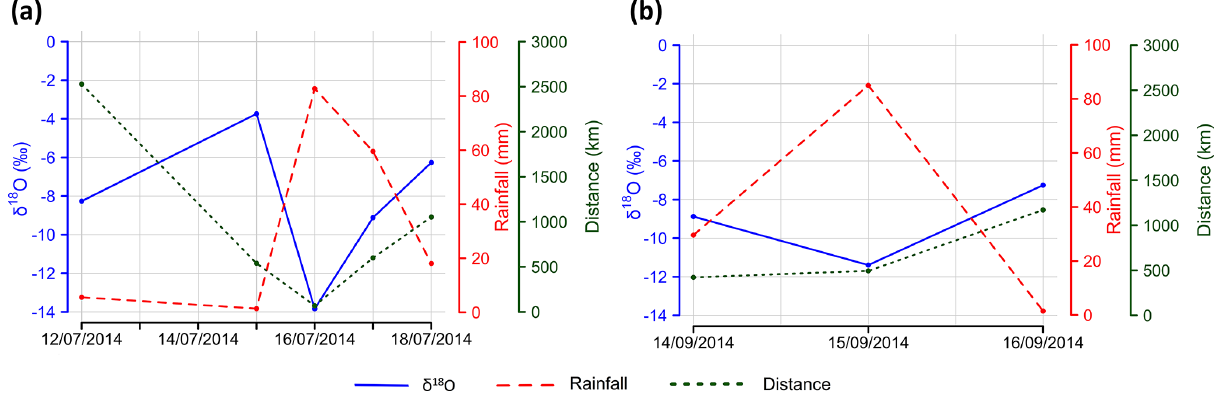
Figure 7. Isotopic signature from TCs during their passage to the Metropolitan Manila sampling site. δ 18 O (blue), distance from the storm’s centre to sampling location (green), and daily rainfall amount (red) for (a) Rammasun and (b) Kalmaegi. Please note that the date format in this figure is